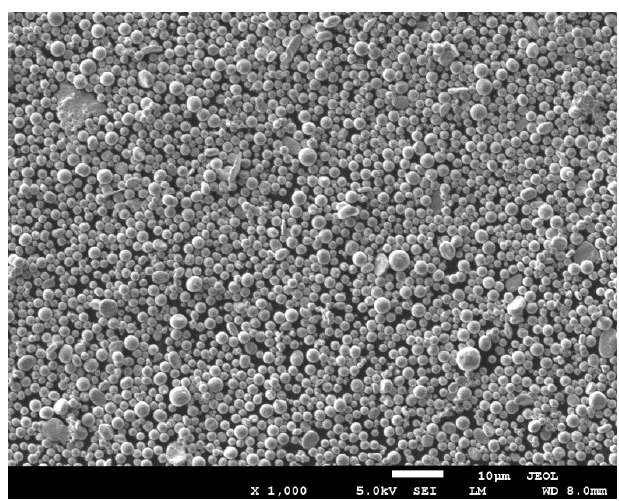
Figure 3. Scanning electron microscopy (SEM, Supra 35, Zeiss manufactuer, Gliwice, Poland) image of the copper grains used for the CuXX component fabrication.